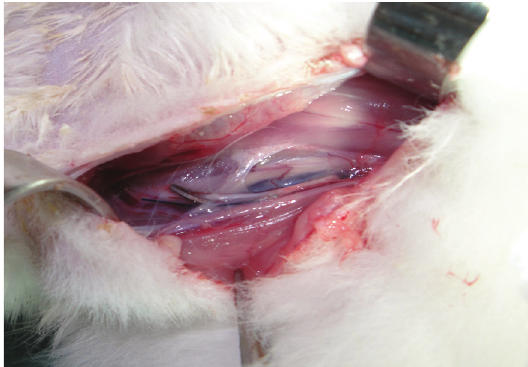
FIGURE 4 - Absence of discontinuity in the group of nerve clipping.